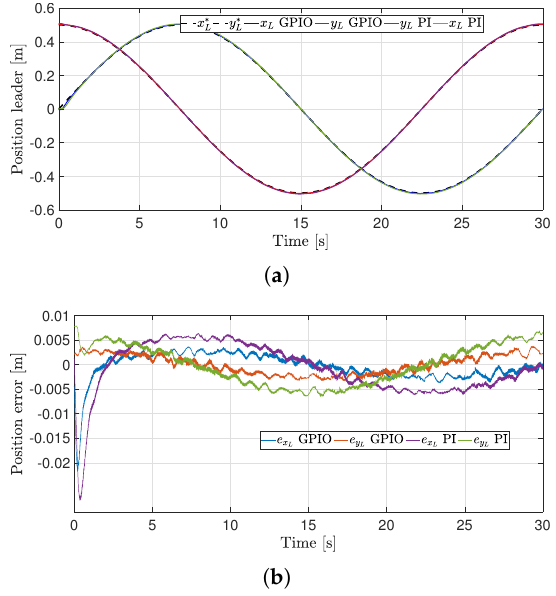
Figure 5. Leader trajectory tracking performance. ( a ) Leader tracking for the first experiment. ( b ) Leader trajectory